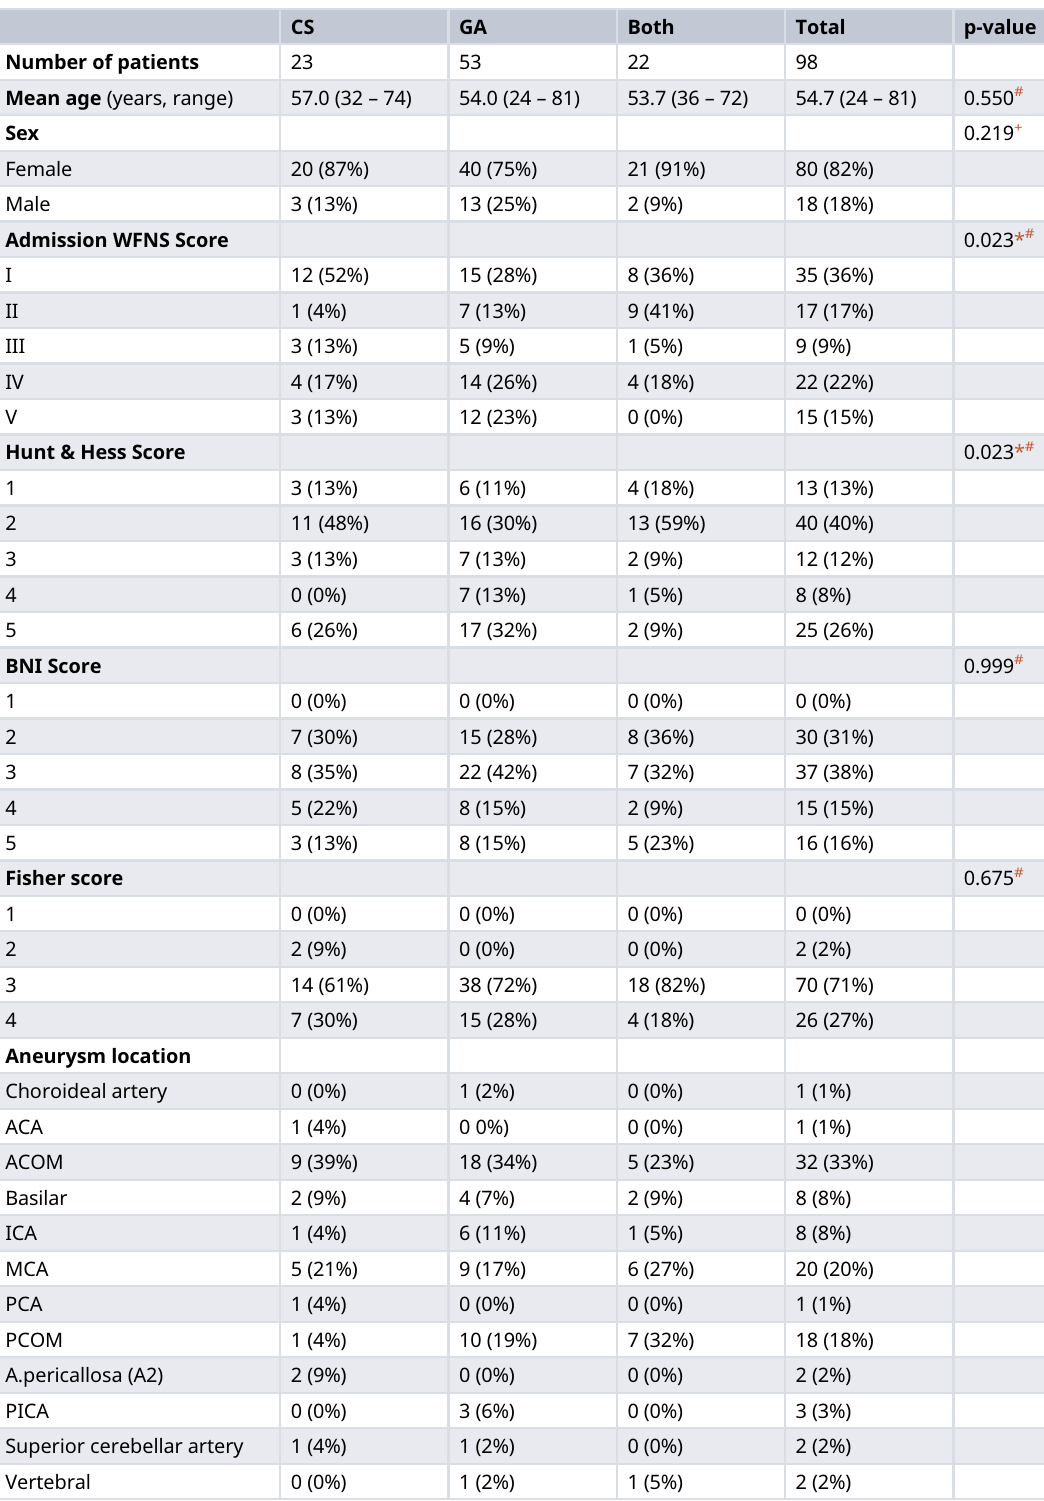
Table 1. Patient